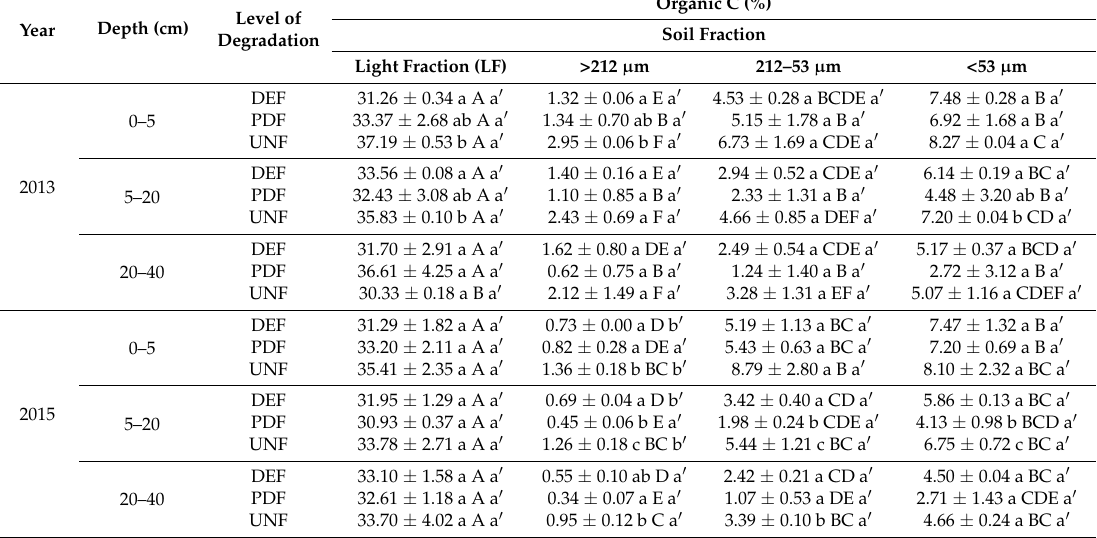
Values with the same lower case letter among levels of degradation and within a same year, depth, and soil fraction are not significantly different (Student’s t test, ** p < 0.01). Values with the same higher case letter among the three depths and one level of degradation between distinct soil fractions are not significantly different (Tukey’s HSD test, * p < 0.05). Values with the same lower case letter (a (cid:48) or b (cid:48) ) between years and within a same depth, level of degradation, and soil fraction are not significantly different (Student’s t test, * p <